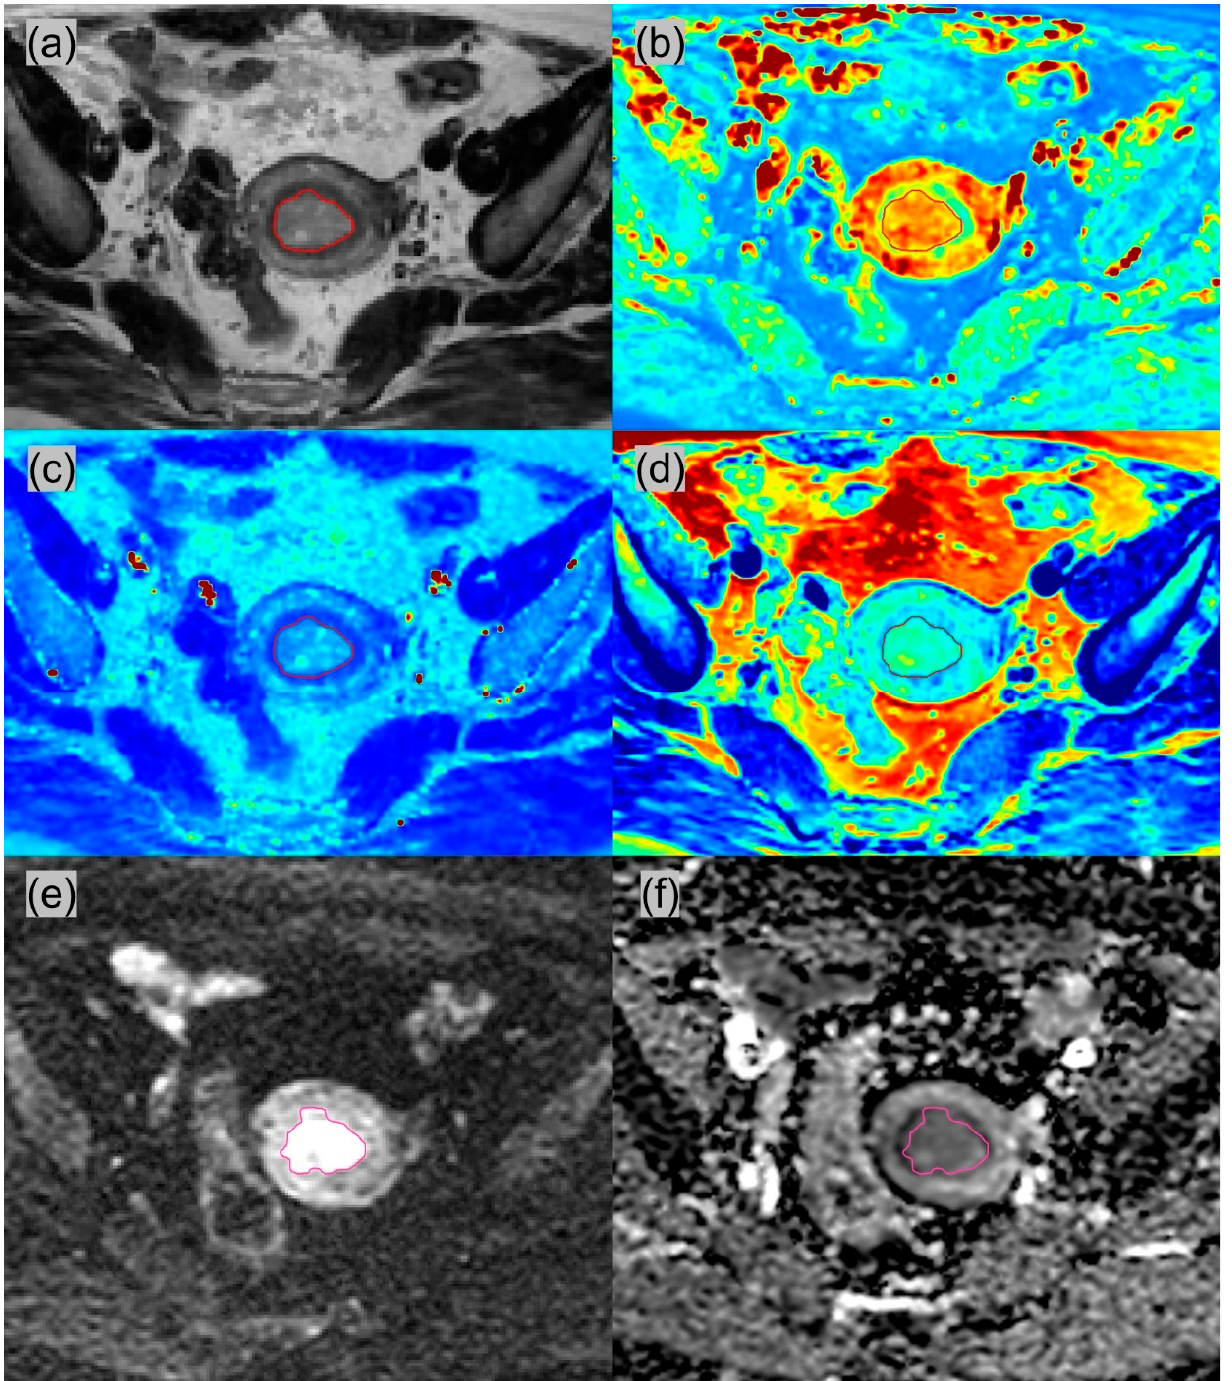
Figure 2. A 59-year-old woman with well-differentiated G1, FIGO stage IA endometrioid adenocar- cinoma. The tumor had superficial myometrial invasion but without cervical stromal involvement or lymphovascular invasion. ( a ) Synthetic T2-weighted image; ( b ) T1 map; ( c ) T2 map; ( d ) PD map; ( e ) diffusion-weighted image with b = 800; ( f ) ADC map. The ROI was delineated on Synthetic T2WI and DWI. The mean value of all voxels within the ROIs: T1 = 1210.0 msec; T2 = 134.4 msec; PD = 86.1 pu; ADC = 1.201 × 10 − 3 mm 2 /s. PD, proton density; ADC, apparent diffusion coefficient.